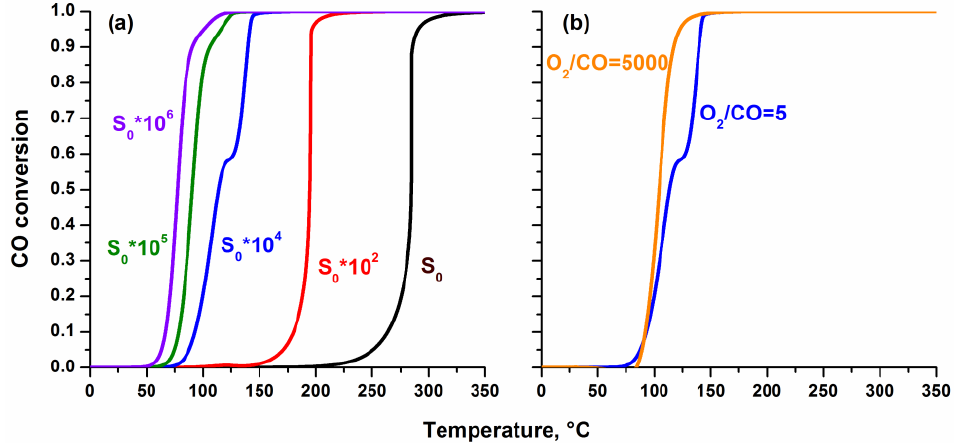
Figure 9. Temperature dependencies of CO conversion at different values of ( a ) the area of the catalyst surface (S 0 is the area of the Pt foil surface) and ( b ) O 2 /CO ratio (the inlet CO concentration—0.2 vol%). The fitted kinetic parameters are k 1 = 6.75 × 10 4 s − 1 mbar − 1 , k − 1 = 8 × 10 8 e − 13 RT s − 1 , k 2 = 750 s − 1 · mbar − 1 , k 3 = 3 × 10 12 e − 27 RT s − 1 , k 4 = 10 12 e − 25 RT s − 1 , and k 5 = 1.5 × 10 13 e − 25 RT s − 1 · bar − 1